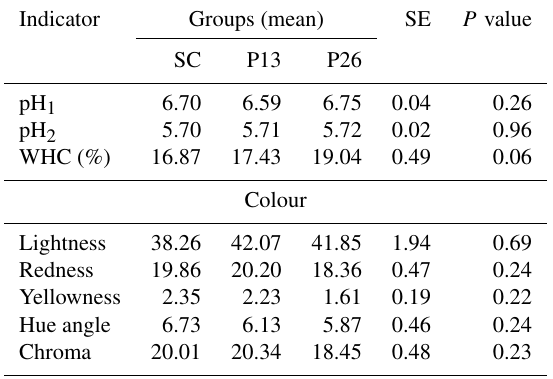
Table 7. Physical properties of lamb